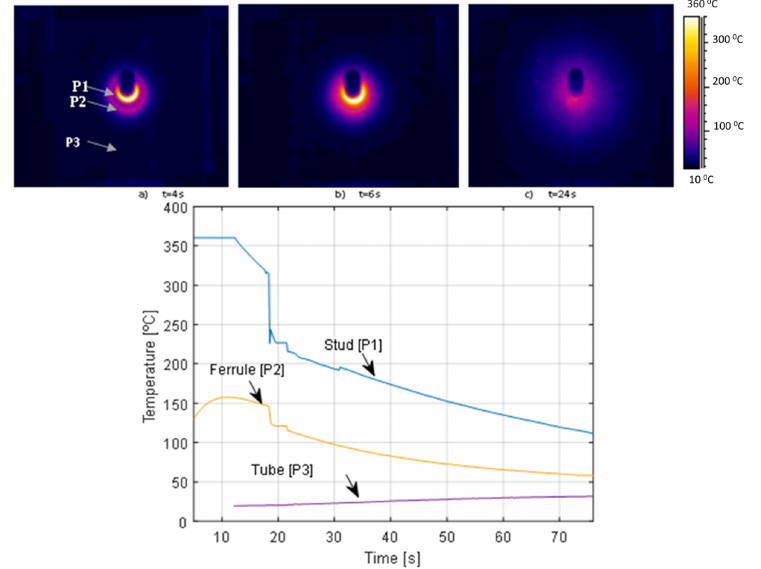
Figure 2. Distribution of temperatures along the tube surface: ( a ) 4 s after the arc welding, ( b ) 6 s after the arc welding, and ( c ) 24 s after the arc welding. In the graph, cooling rate of stud (P1), ceramic ferrule (P2), and tube (P3).